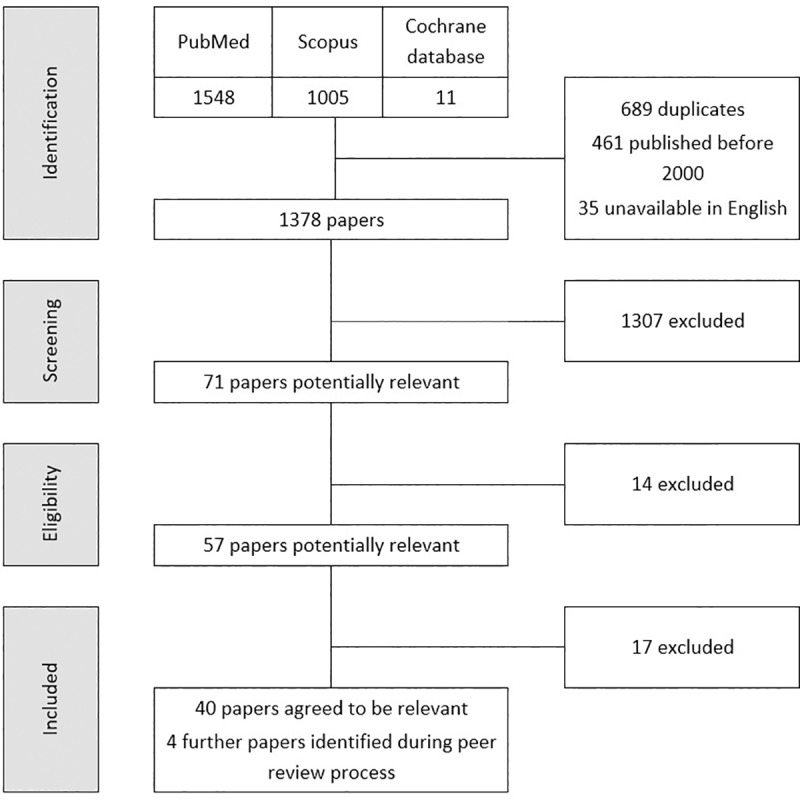
PRISMA flow diagram.